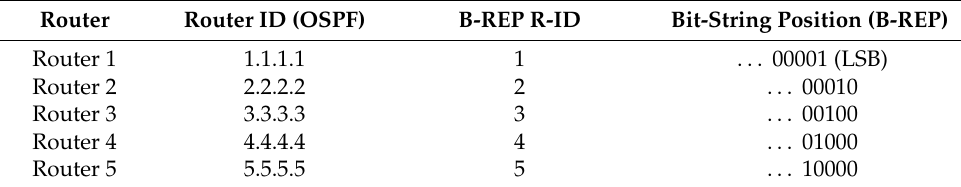
Table 2. B-REP Table—Bit-String allocation according to B-REP